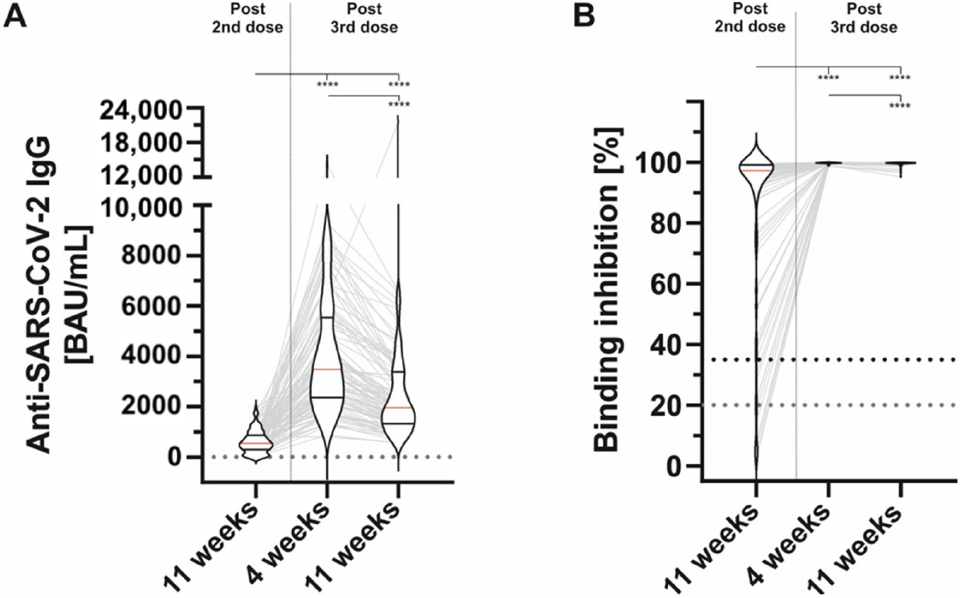
Figure 1. The vaccine induced serological immune response at different timepoints post second and third doses of BNT162b2. ( A ): Anti-SARS-CoV-2-IgG at different timepoints (left: 11 weeks post second vaccine dose, right: 4 and 11 weeks after third vaccine dose, respectively). ( B ): Binding inhibition at different timepoints (left: 11 weeks post second vaccine dose, right: 4 and 11 weeks after third vaccine dose, respectively). Horizontal lines within plotted data show the median (red line) and interquartile ranges. **** p < 0.0001 (Mann–Whitney U-test).